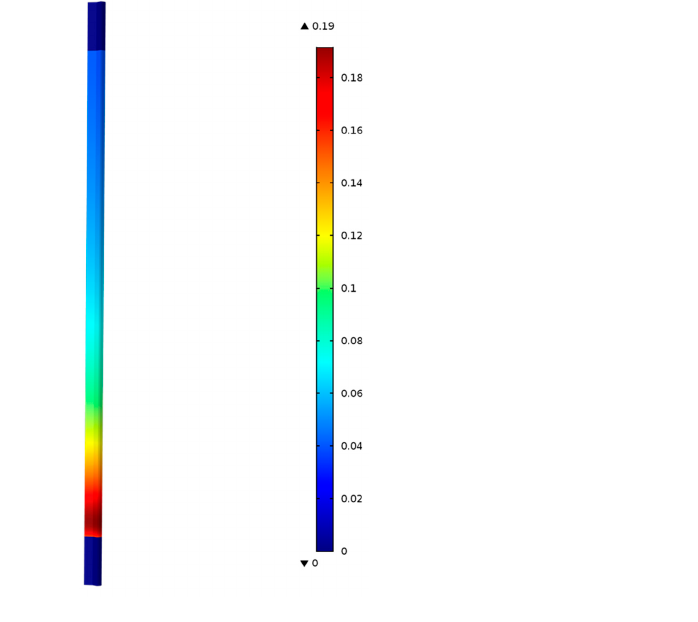
Figure 5. Contours of propene formation rate mol/(m 3 s), RC 3 H 6 , at 300 °C and 20 bar total pressure.